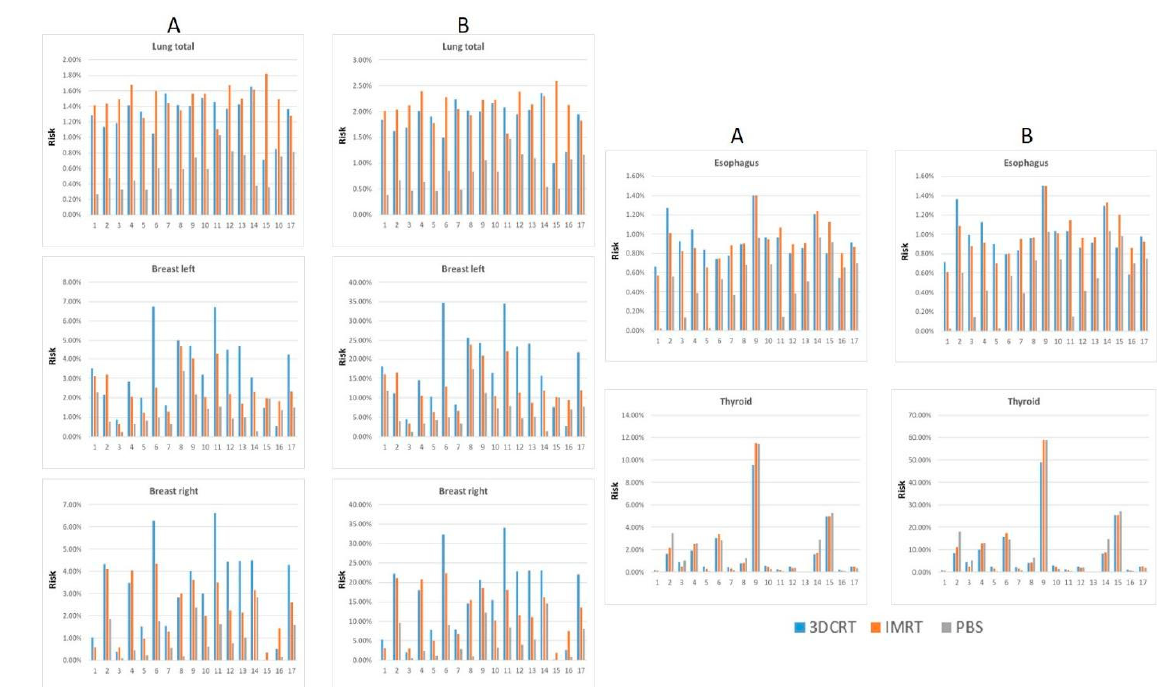
Figure 1. Calculated risk of total ( A ) and fatal ( B ) cancer induction for 3DCRT (blue) IMRT (red) and PBS (grey) plans for the respective organs at risk (lung, left and right breast, as well as esophagus and thyroid) according to the Dasu model for each patient.